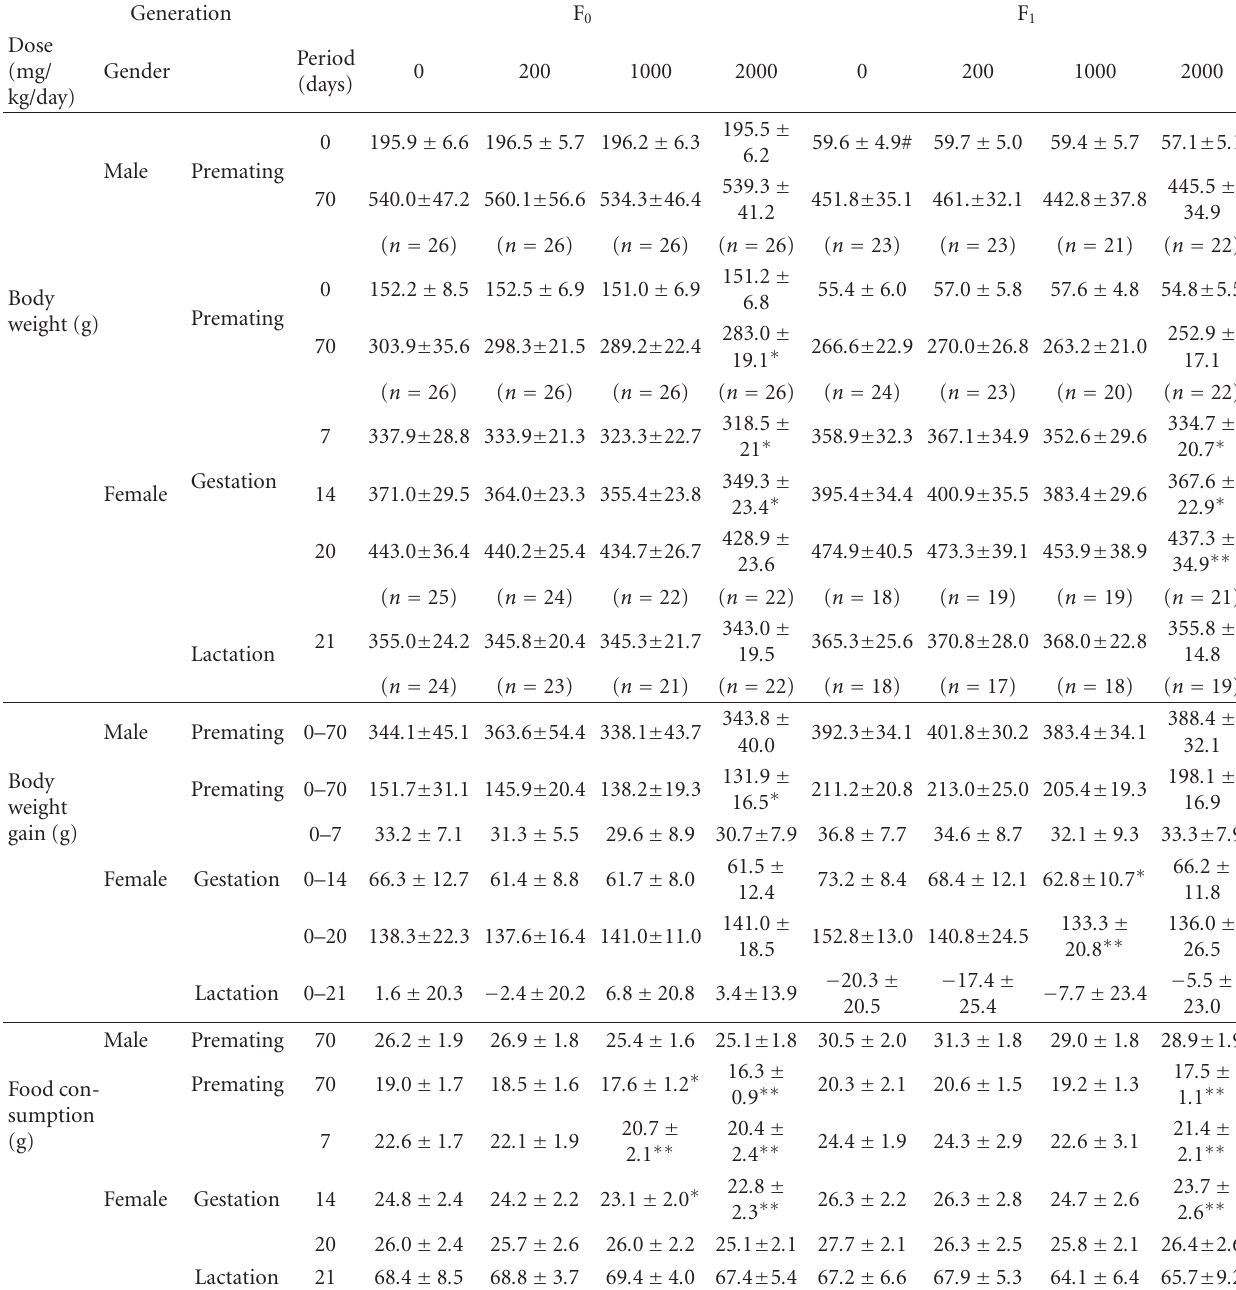
Table 3: Body weight and food consumption in male and female Sprague-Dawley rats during the two-generation reproductive toxicity study. Generation F 0 F